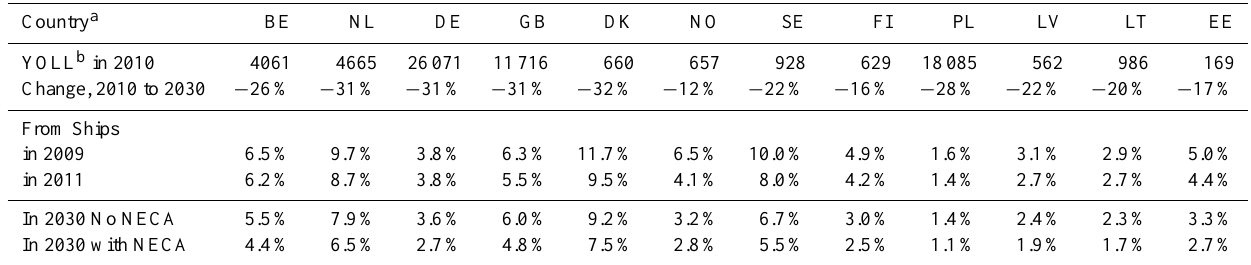
Table 2. The first row gives the total number of years of life lost (YOLLs) summed up per country calculated with 2010 emissions (ship emissions in the Baltic Sea and the North Sea for 2009). Also listed are the percentage reductions from 2010 to 2030 under current regulation (second row), and the share from shipping calculated with ship emissions for 2009 and 2011 relative to the 2010 land based emissions (under “From Ships”). The percentage contribution from shipping in 2030 is listed both with and without a NECA implemented in the two sea areas (last two rows). Reductions in YOLLs from shipping are mainly caused by stricter controls of ship emissions of SO x .